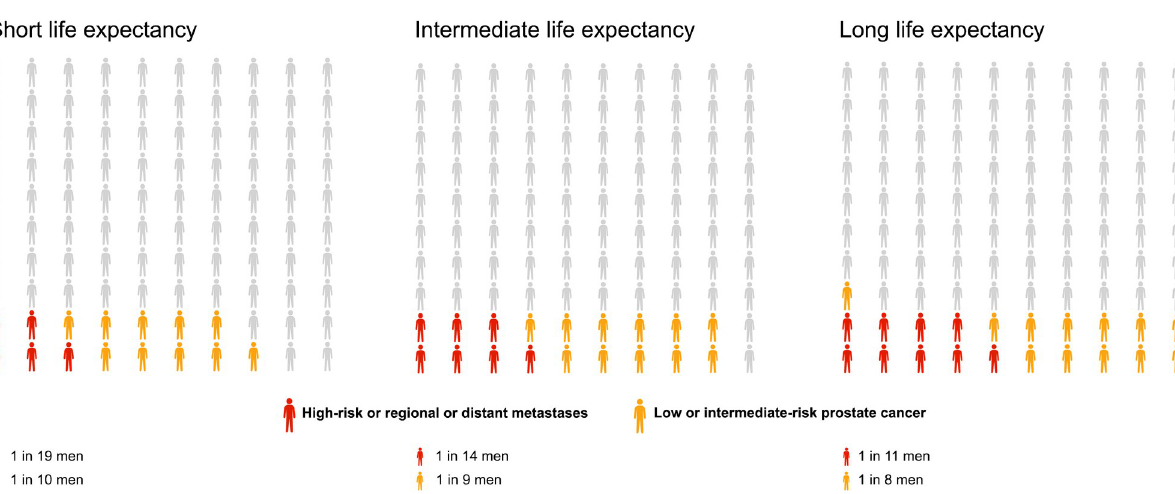
Fig 4. Lifetime risk of low to intermediate-risk prostate cancer diagnosis (in blue), and high risk or metastatic prostate cancer (in red) under three levels of life expectancy: Short as for birth cohort 1912; Intermediate as for birth cohort 1952; Long as for birth cohort